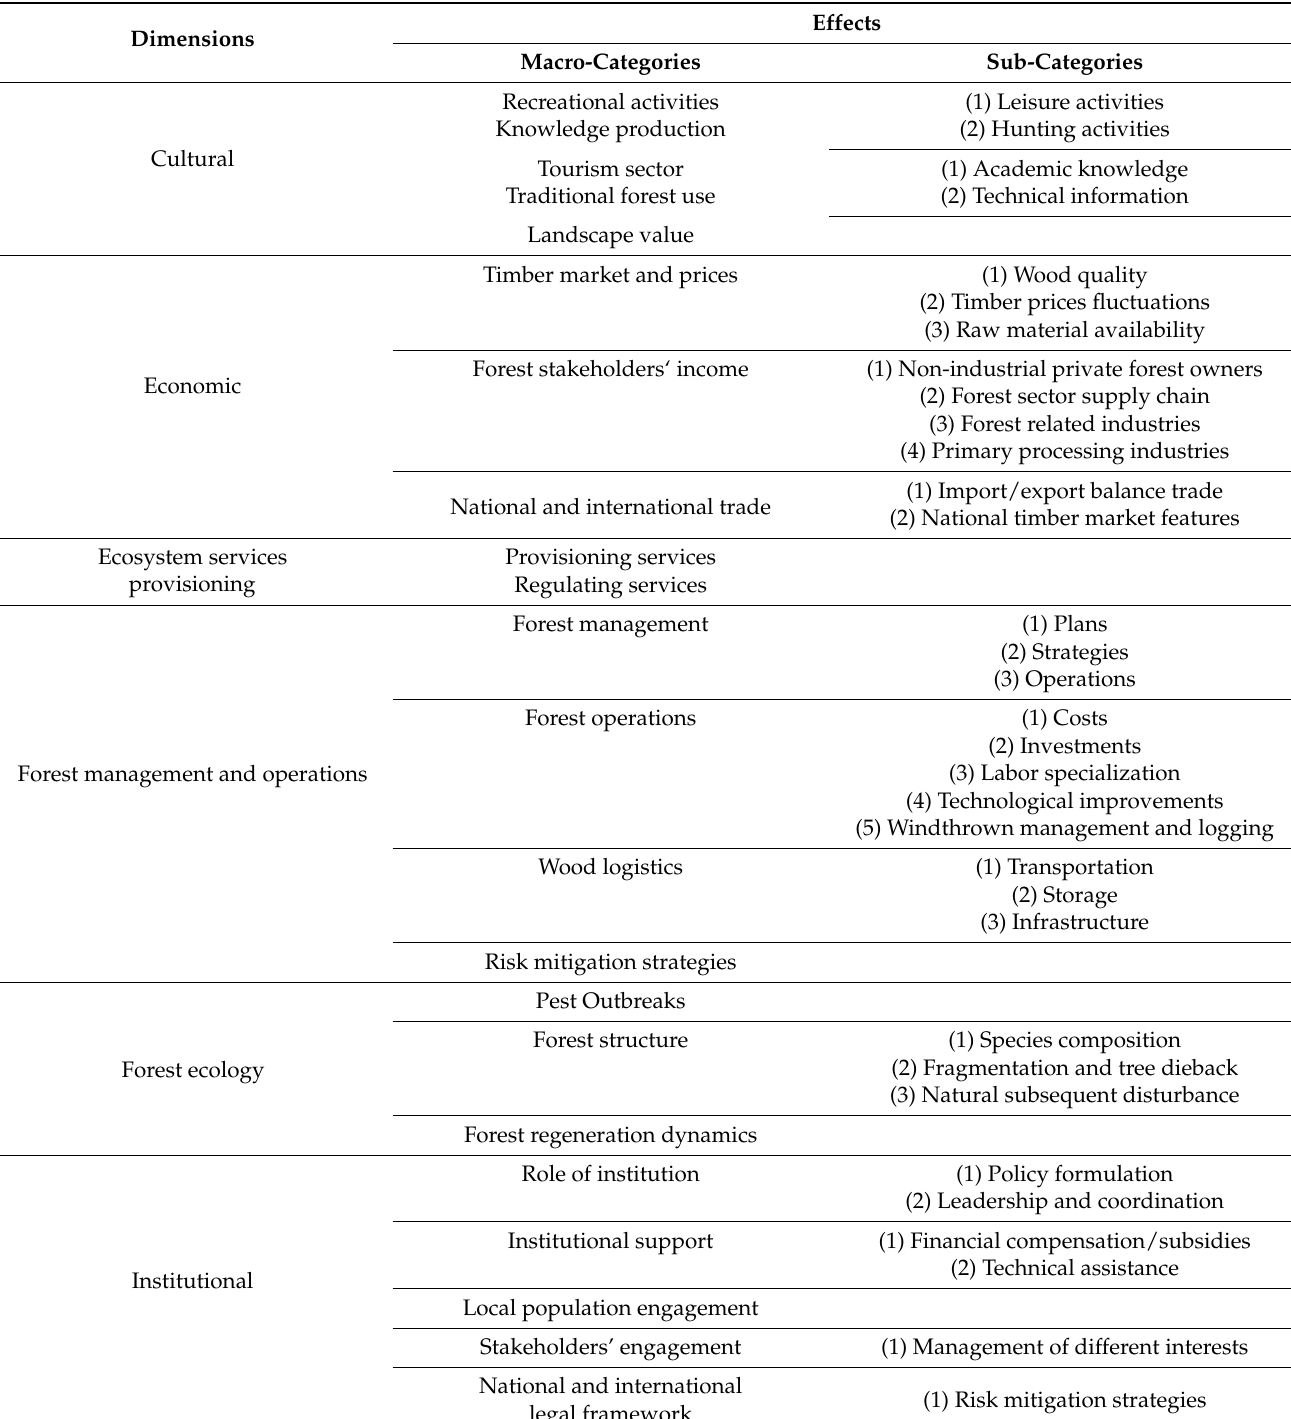
Table A2. List of dimensions, macro-categories and sub-categories used in data